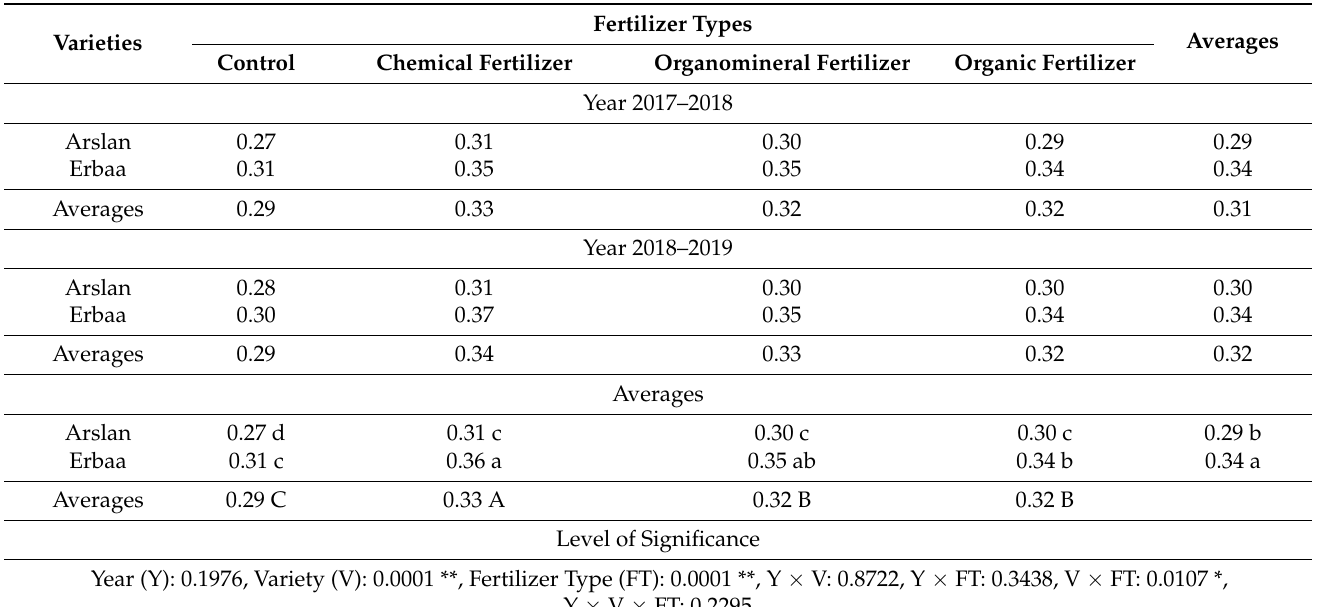
Table 9. The effect of fertilizer types on the essential oil ratio of coriander varieties (%) 1 .